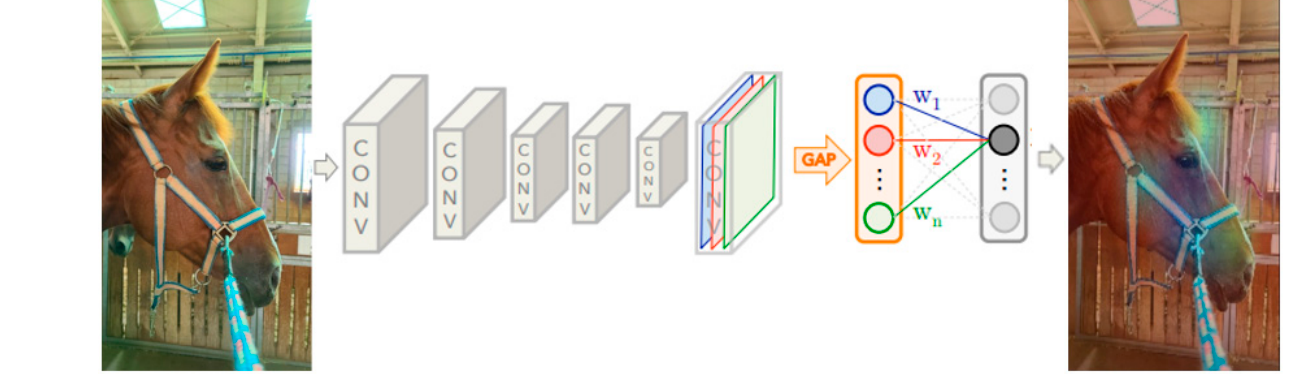
Figure 5. Architecture of class activation mapping; the predicted class scores are remapped to previous convolution layers to generate class activation maps (CAMs). The CAM highlights the class-speci fi c discriminative regions.